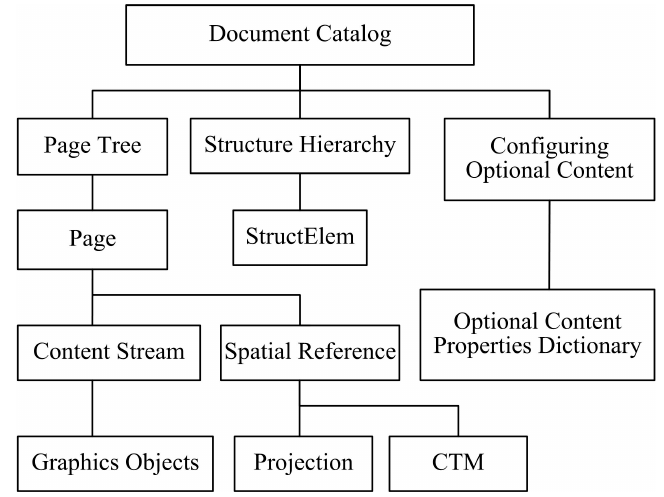
Figure 5. Document structure chart of a single PDF tile. CTM (coordinate transformation matrix), StructElem (structure elements).